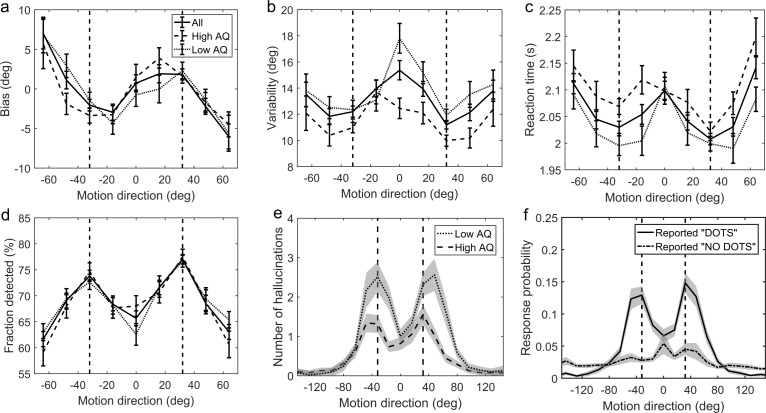
Average group performance on low-contrast trials (a–d) and on trials with no stimulus (e).(a) Mean estimation bias, (b) standard deviation of estimations, (c) estimation reaction time and (d) fraction of trials in which the stimulus was detected. (f) Probability distribution of estimation responses on trials without stimulus. The solid line denotes the estimation responses when participants reported detecting a stimulus (hallucinations). The dash-dot line denotes estimation distributions when participants correctly reported not detecting a stimulus. (e) Distribution of hallucinations for high and low AQ groups (median split). The vertical dashed lines correspond to the two most frequently presented motion directions (±32°). Error bars and shaded areas represent within-subject standard error.10.7554/eLife.34115.005Figure 3—source data 1.This zip archive contains .csv files with all of the data that was used to produce plots in Figure 3.EstimationBias.csv contains estimation biases at each of the nine presented angles. EstimationVariability.csv contains standard deviation of estimations at each of the nine presented angles. NostimDetected.csv and NostimUndetected.csv contain estimation responses when stimulus was detected and not detected, respectively, on no-stimulus trials. Traits.csv contains AQ scores of each individual (column 3) as well as all other traits. SourceData_Readme.txt contains more detailed description of each data file. The plots can be reproduced from MATLAB script master.m which is available in the provided Source code 1. SourceCode_Readme.txt contains more detailed description of the source code.